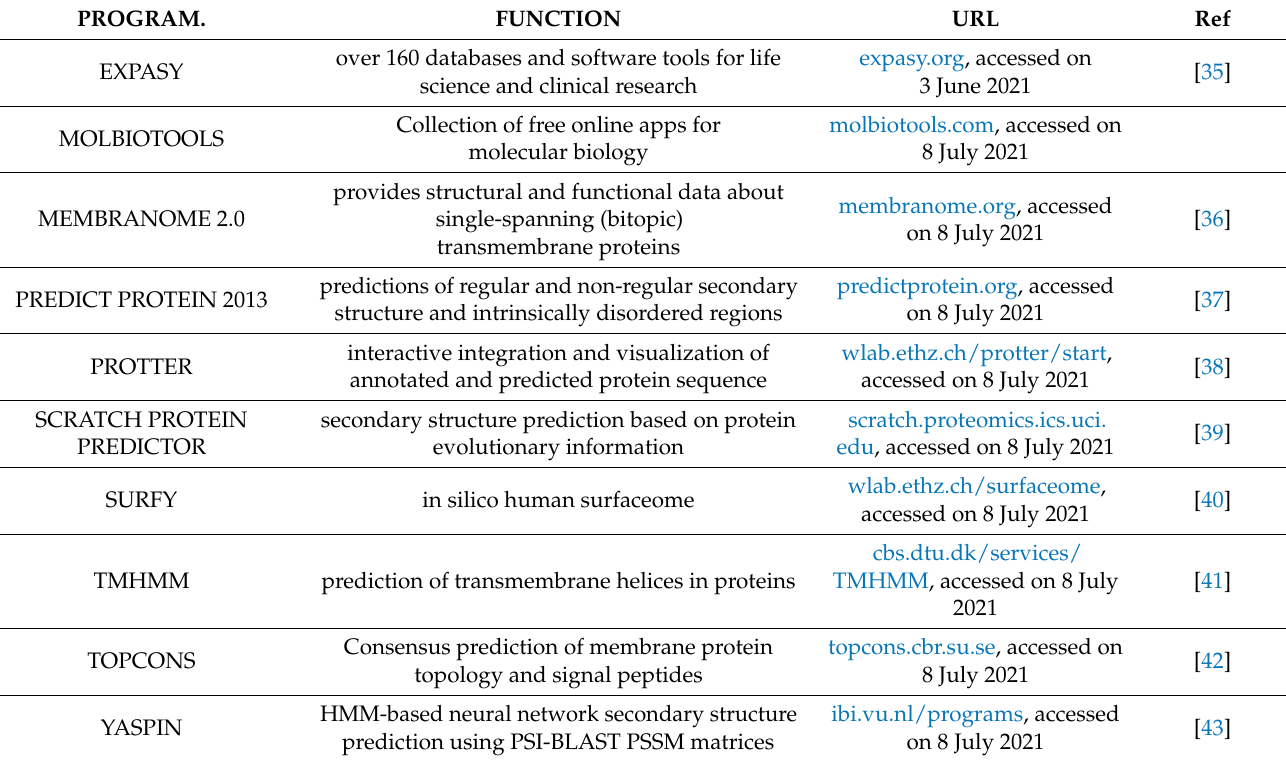
Table 1. Programs for the analysis of membrane topology